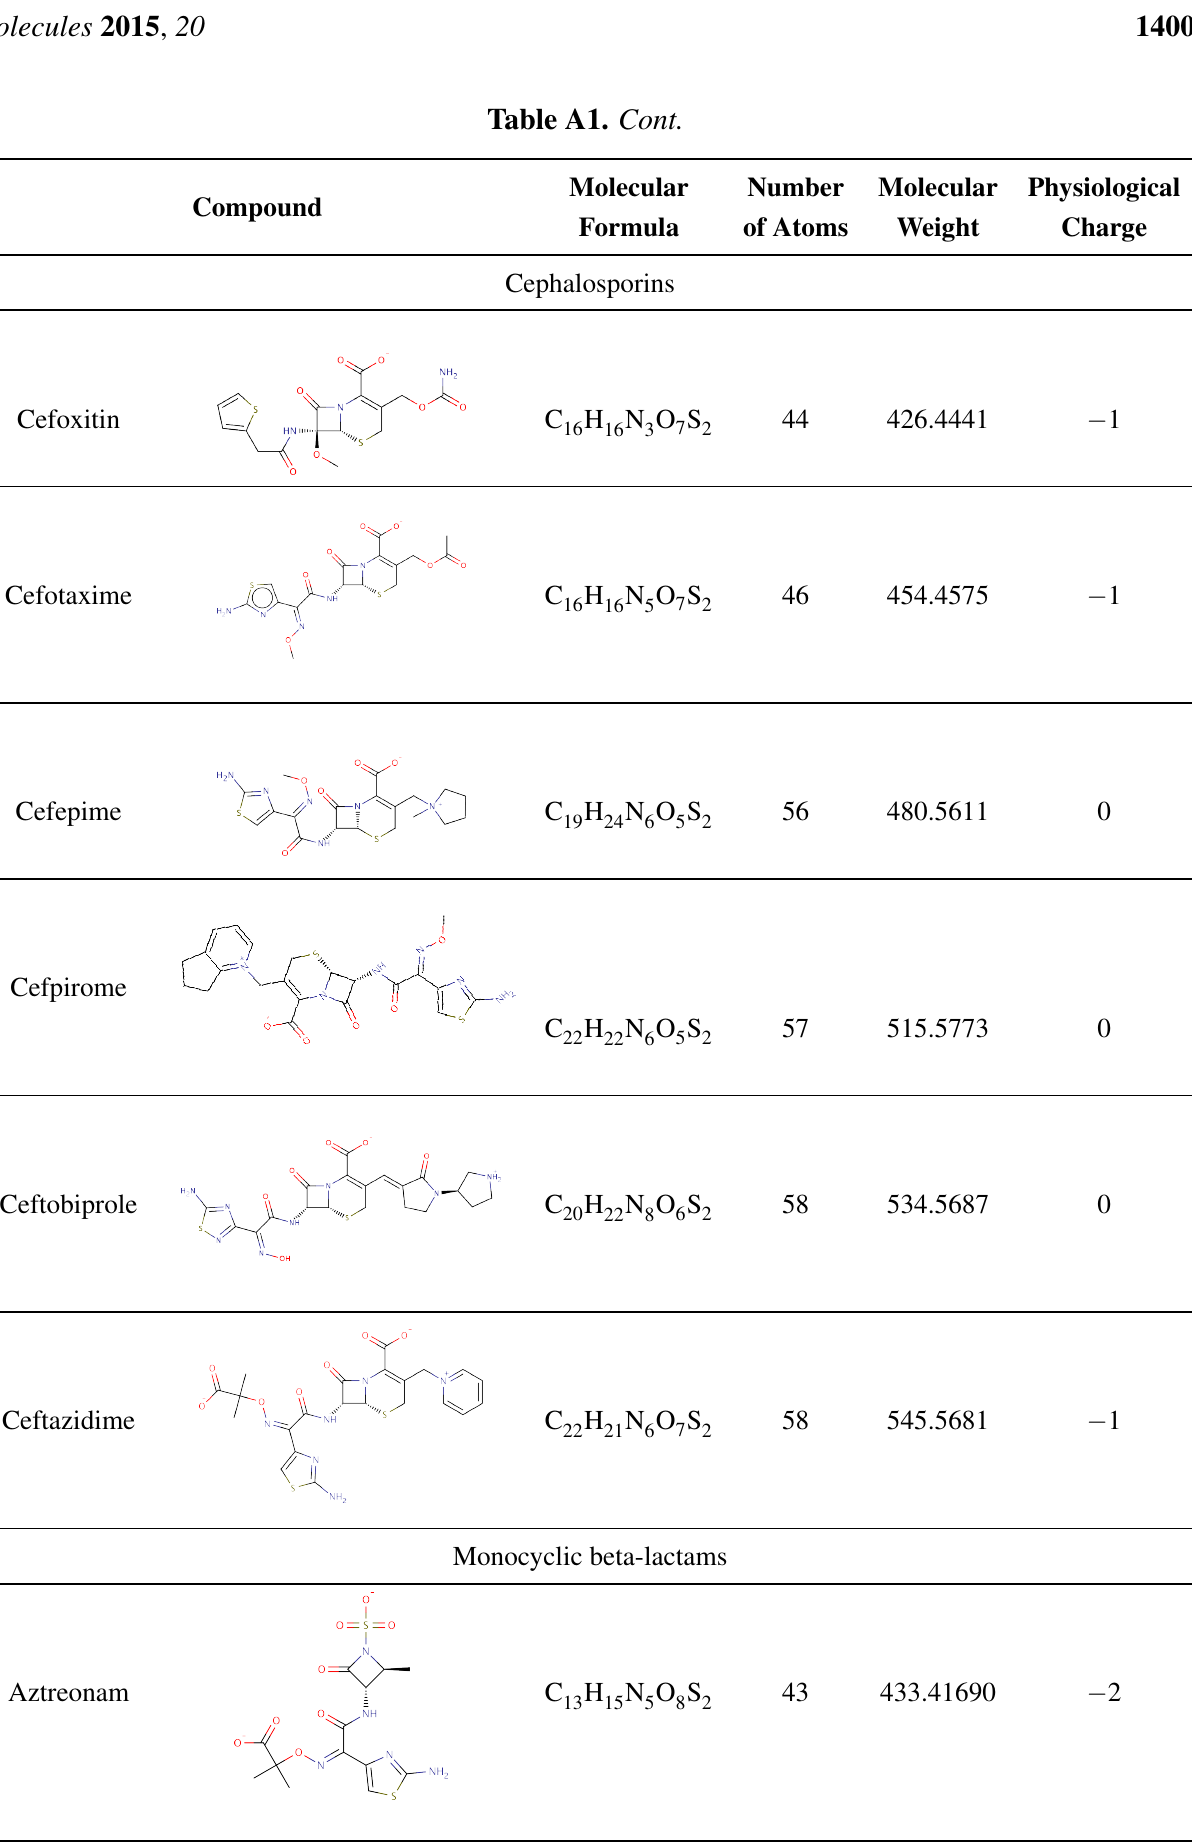
Table A1. Cont. Molecular Number Molecular Compound